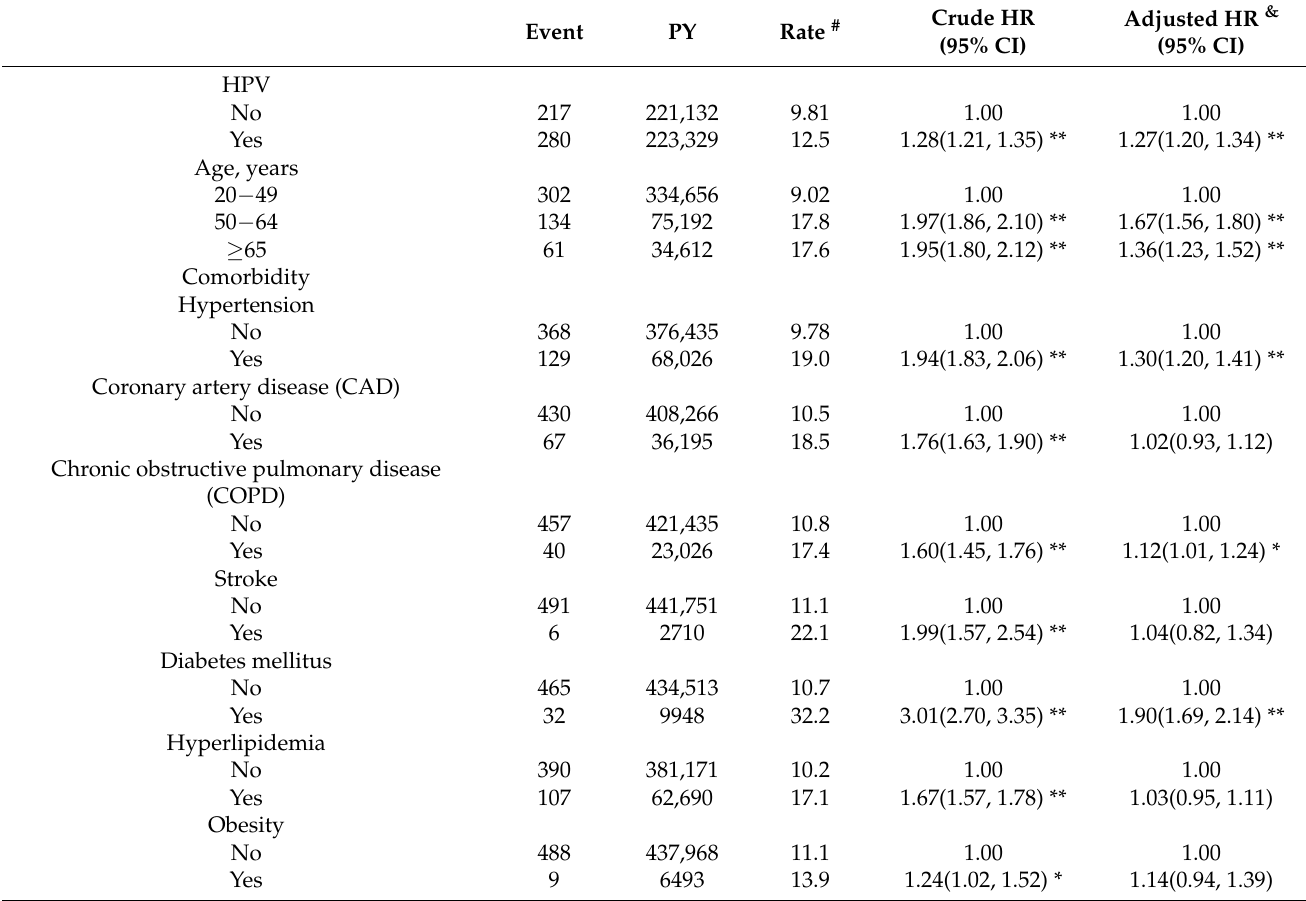
Table 2. Incidence of and risk factors for breast